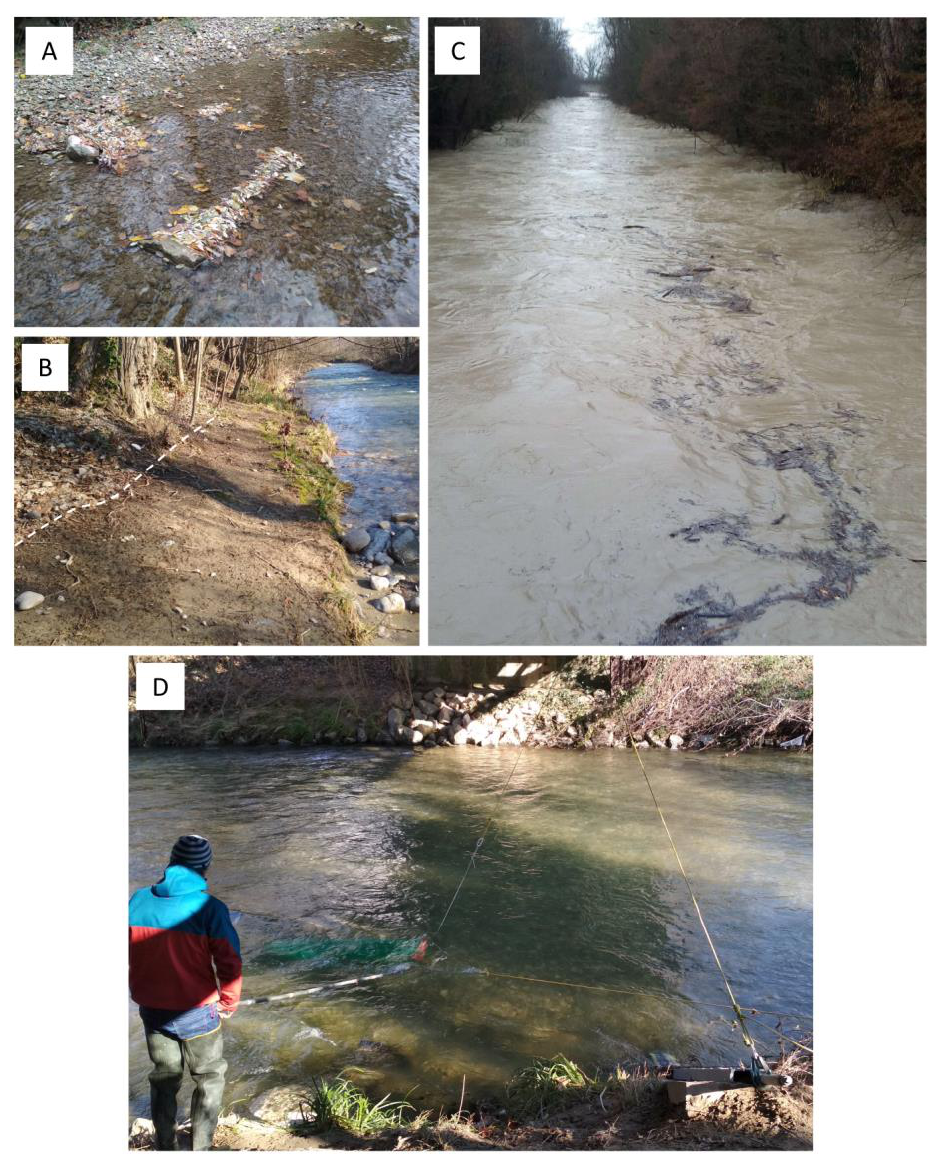
Figure 2. Pictures of the Lower Leysse River at the university bridge. ( A ): riverbed at low flow with litter accumulations upstream of boulders (13 November 2018, Q: 1 m 3 s −1 , water depth: 20 cm, width: 14 m); ( B ): river bank on 19 March 2019, after a high flow event. The white dotted line indicates the highest level reached by the stream. ( C ): Brown turbid water during a rising limb at very high flow (Q: 170 m 3 s −1 , water depth: 3.4 m, width: 20 m) with floating logs and branches in the middle of the river; ( D ): sample collection using the hanging net technique during a falling limb (Q: 9.4 m 3 s −1 , water depth: 0.8 m): note the water transparency.